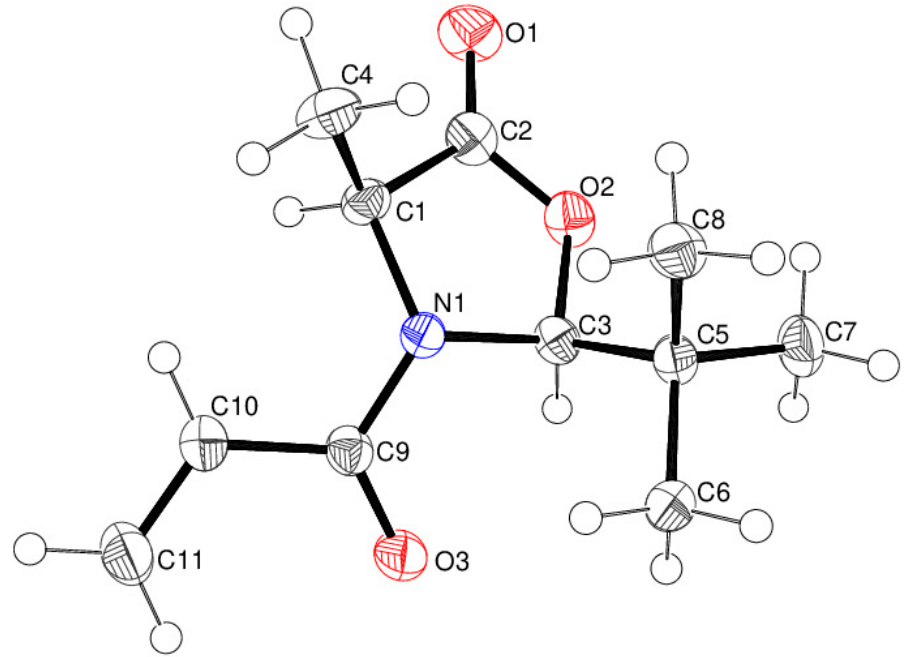
Figure 1. The asymmetric unit of ( I ) showing 50% displacement Figure 1. the asymmetric unit of ( I ) showing 50% displacement ellipsoids. The C1/C2/O2/C3/N1 five-membered ring adopts a shallow envelope conformation with C3, which bears the tert -butyl group, as the flap, which deviates by 0.124 (3) Å from the other four atoms (r.m.s. deviation = 0.0007 Å): the Cremer–Pople (CP) [17] puckering parameters for the ring are Q (2) = 0.077 (2) Å and φ (2) = 320.9 (15)° (pivot atom O2). These data may be compared with the ring torsion angles shown in Table 1. The C4 methyl (at C1) and C5 tert -butyl (at C3) substituents attached to the stereogenic carbon atoms lie to the same side of the ring in what is called the cis arrangement for these systems [4] with C4 and C5 deviating from the ring plane (all atoms) by 1.221 (2) and 1.325 (2) Å, respec- tively. As expected, the absolute structure of ( I ) was indeterminate in the present diffrac- tion experiment using Mo K α radiation but based on the L-alanine starting material, we assign S configurations to both C1 and C3. The bond-angle sum at N1 of 352.7° indicates a hybridisation state closer to sp 2 than sp 3 but some pyramidalization is evident resulting in the displacement of the acrolyl substituent away from the face of the ring bearing the methyl and tert -butyl substituents perhaps due to steric reasons. The C9–N1 bond length of 1.372 (2) Å suggests some delocalisation of the nominal N lone-pair electrons with the carbonyl group. Atoms C1 and O3 are close to anti about the C9–N1 bond [C1–N1–C9–O3 = 155.19 (19)°] and O3 and C11 in the allyl side-chain are almost syn [O3–C9–C10–C11 = 0.5 (3)°]. Finally, one of the C atoms of the tert -butyl group is almost anti with respect to H3 [H3–C3–C5–C8 = − 175 (2)°]. Otherwise, the bond lengths and angles in ( I ) may be re- garded as unexceptional. Table 1. key ring torsion angles (°) in ( I )–( III ). Torsion Angle